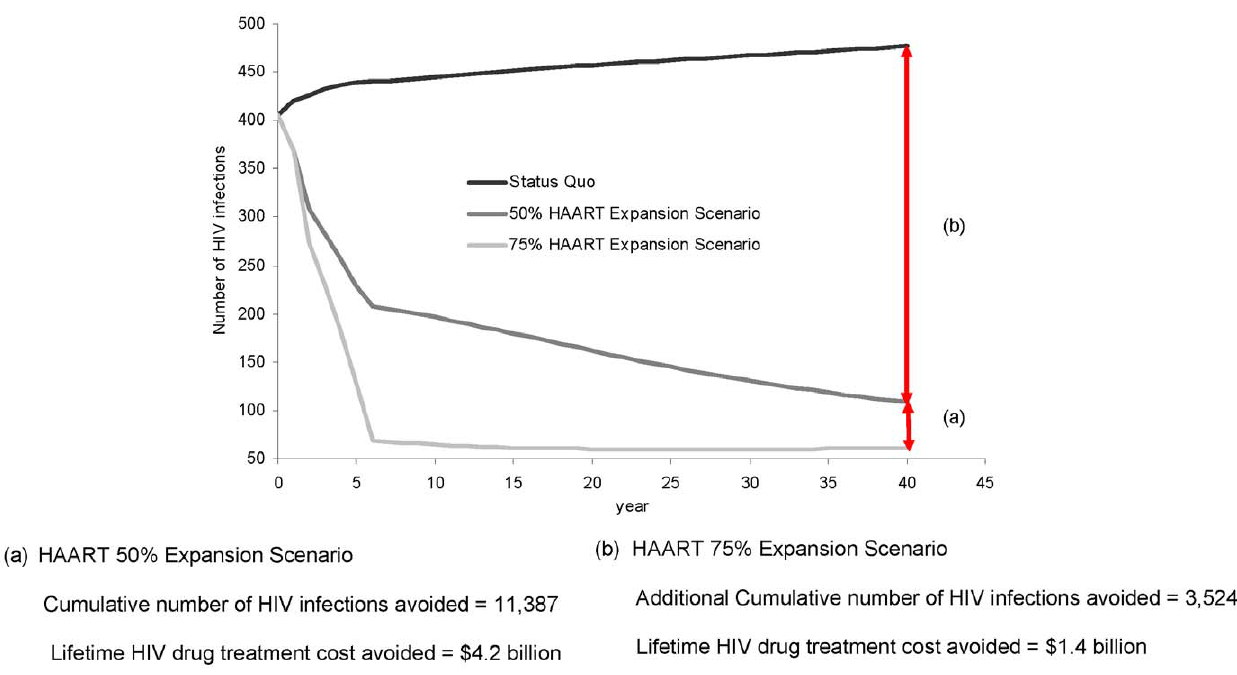
Figure 2. Comparison of the projected number of new HIV infections: Status Quo approach versus 50% and 75% expansion scenarios (over 40 years).